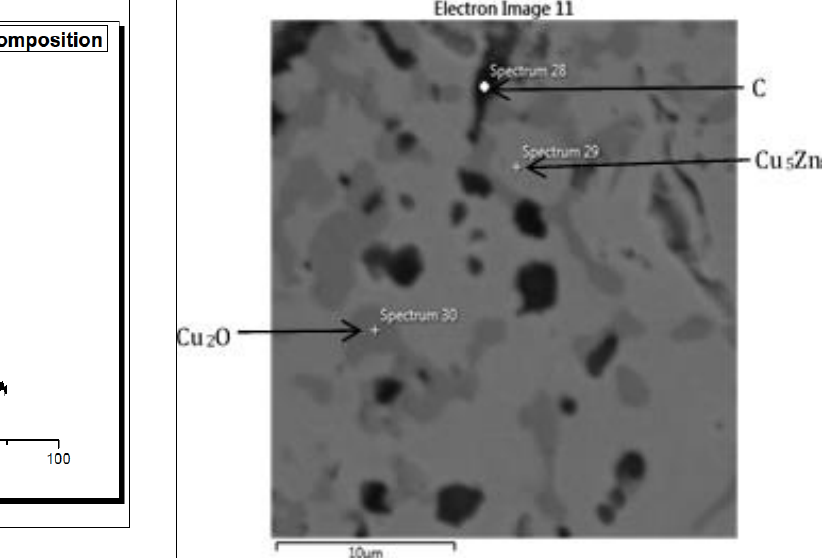
Figure 8: SEM Micrograph of 2% sample.